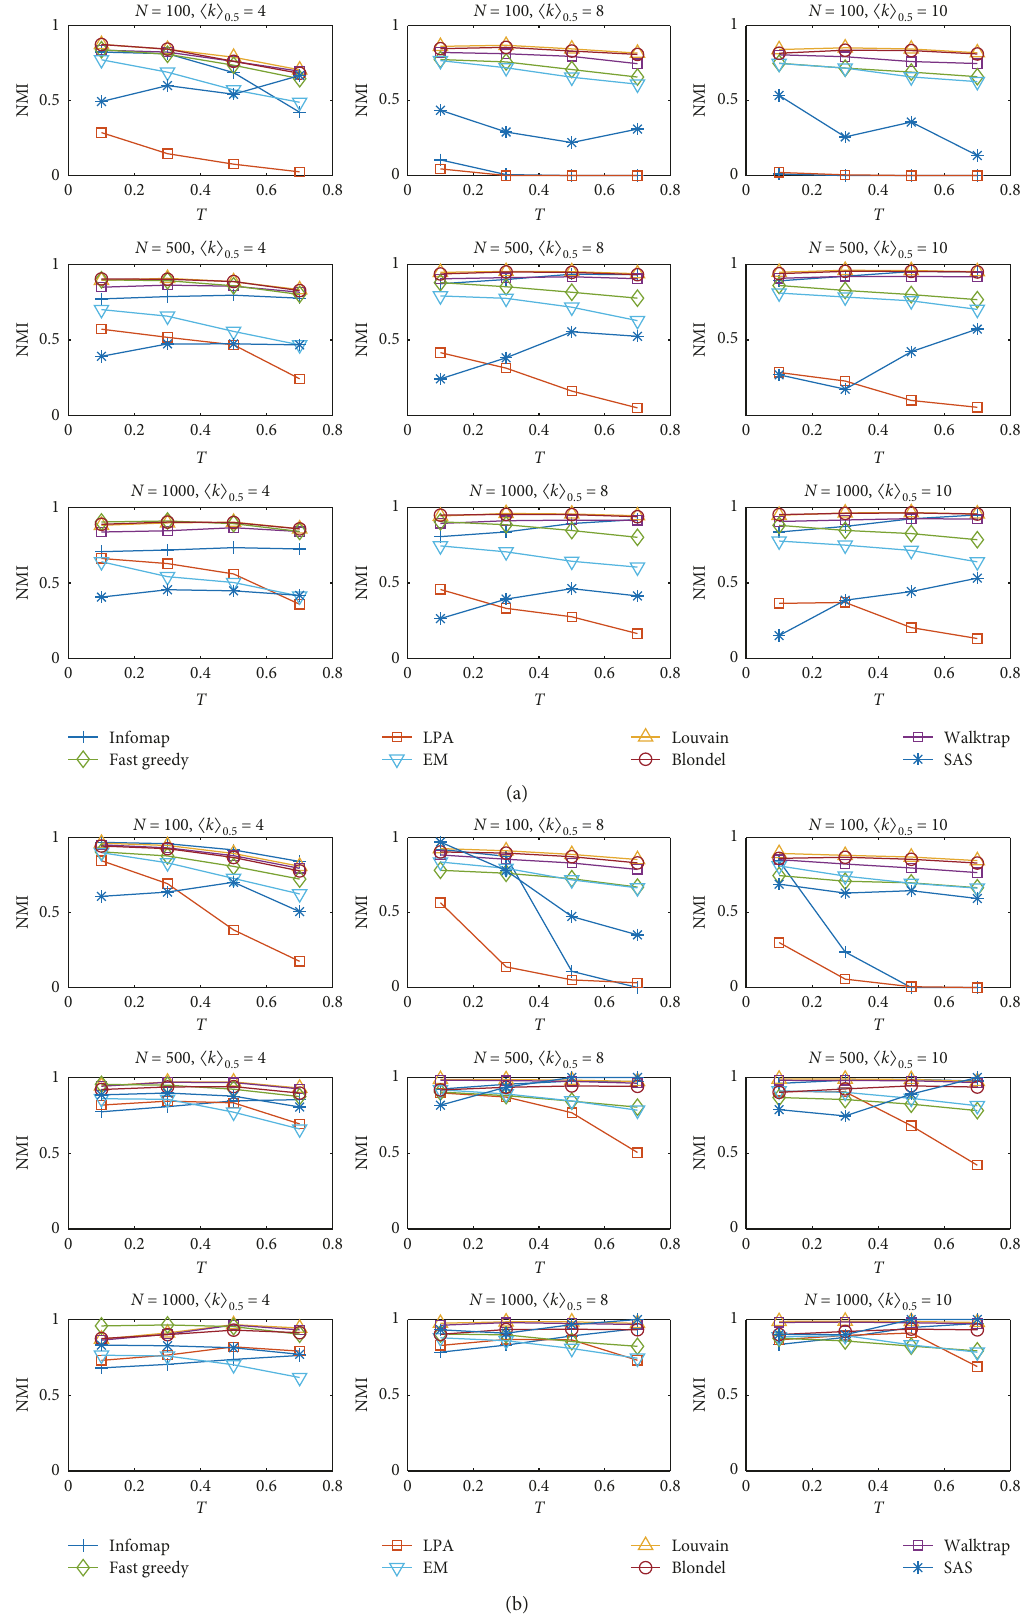
Figure 9: Community detection on nPSO networks. The number of communities n Figure